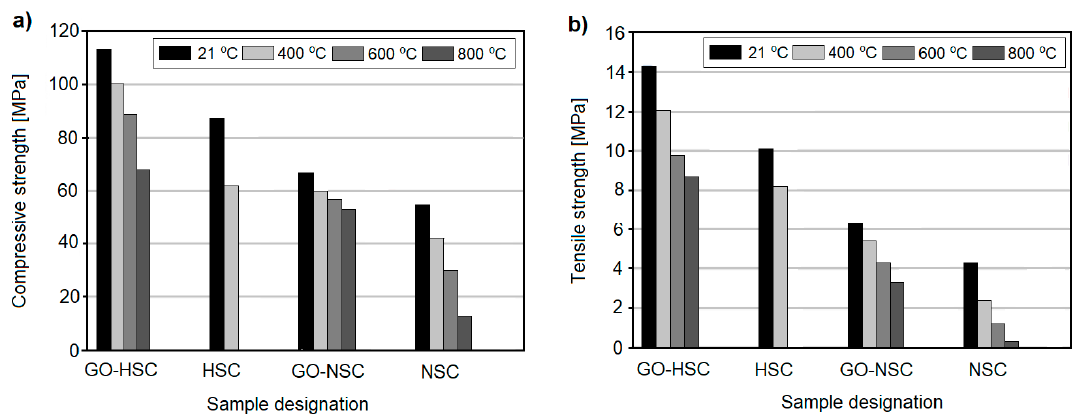
Figure 10. Compressive strength ( a ) and tensile strength ( b ) test results of graphene oxide (GO)-modified high strength concrete (GO-HSC), high strength concrete (HSC), GO-modified normal strength concrete (GO-NSC) and normal strength concrete (NSC) after exposure to elevated temperature. Redrawn from [62].